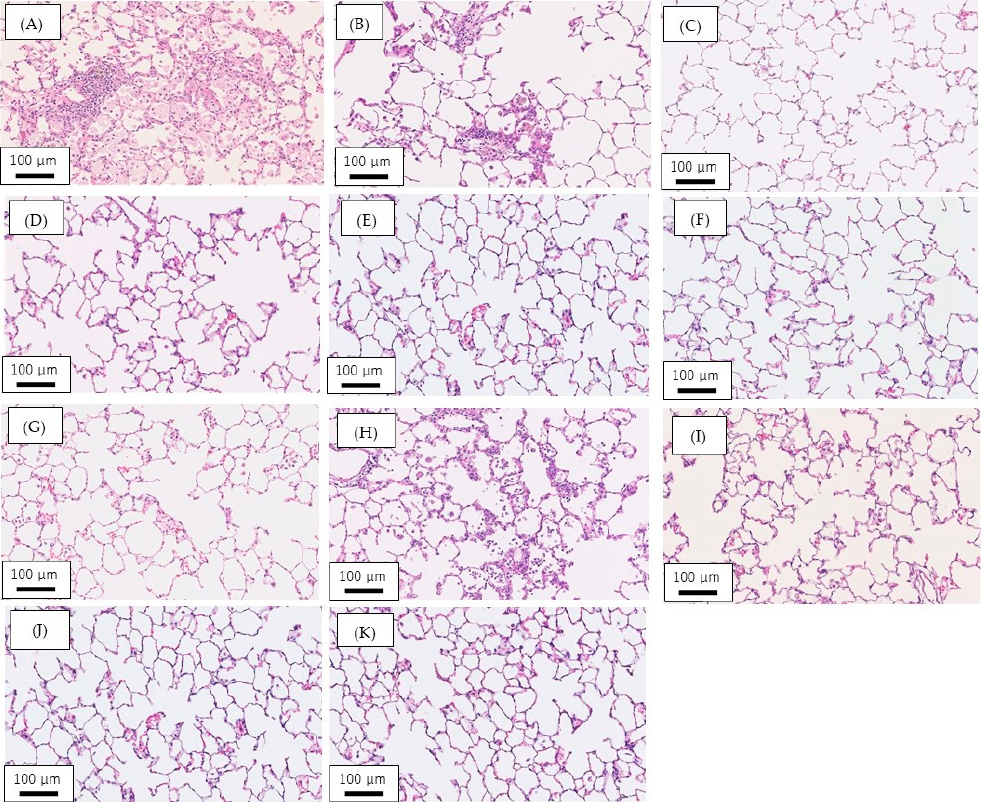
Figure 2. Pathologic features in the rat lung at 6 months after intratracheal instillation and at 3 months after inhalation exposure of NMs. ( A ) 1.0 mg NiO-instilled lung; ( B ) 1.0 mg CeO 2 -instilled lung; ( C ) 1.0 mg TiO 2 (P90)-instilled lung; ( D ) 1.0 mg TiO 2 (rutile)-instilled lung.( E ) 1.0 mg ZnO-instilled lung; ( F ) negative control in intratracheal instillation (distilled water); ( G ) NiO-exposed lung (high concentration: 1.65 ± 0.20 mg / m 3 ); ( H ) CeO 2 -exposed lung (high concentration: 10.2 ± 1.38 mg / m 3 ); ( I ) TiO 2 (rutile)-exposed lung (high concentration: 1.84 ± 0.74 mg / m 3 ); ( J ) ZnO-exposed lung